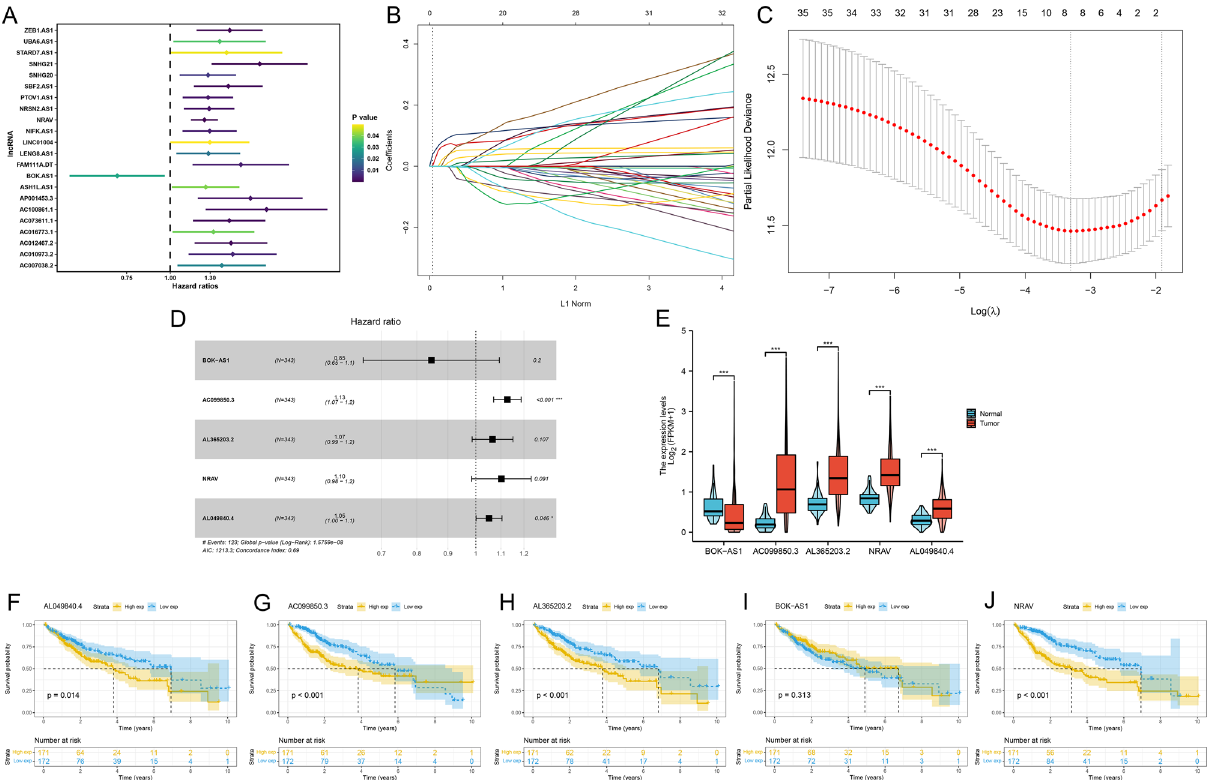
Figure 2. Identification of costimulatory molecule-related lncRNAs with prognostic values. (A) Results of univariate Cox regression analysis of prognostic costimulatory molecule-related lncRNAs in HCC patients. (B, C) LASSO regression analysis of costimulatory molecule-related lncRNAs selected from univariate Cox regression analysis. (D) Results of multivariate Cox regression analysis of prognostic costimulatory molecule- related lncRNAs in HCC patients. (E) Expressions of five prognostic costimulatory molecule-related lncRNAs in HCC and normal tissues. (F) Differential expression analyses of AC099850.3 in HCC and normal tissues from TCGA combined GTEx datasets. (G) Differential expression analysis of AC099850.3 in 50 normal-tumor paired samples. (H) Kaplan–Meier survival curves of five prognostic costimulatory molecule-related lncRNAs in the HCC